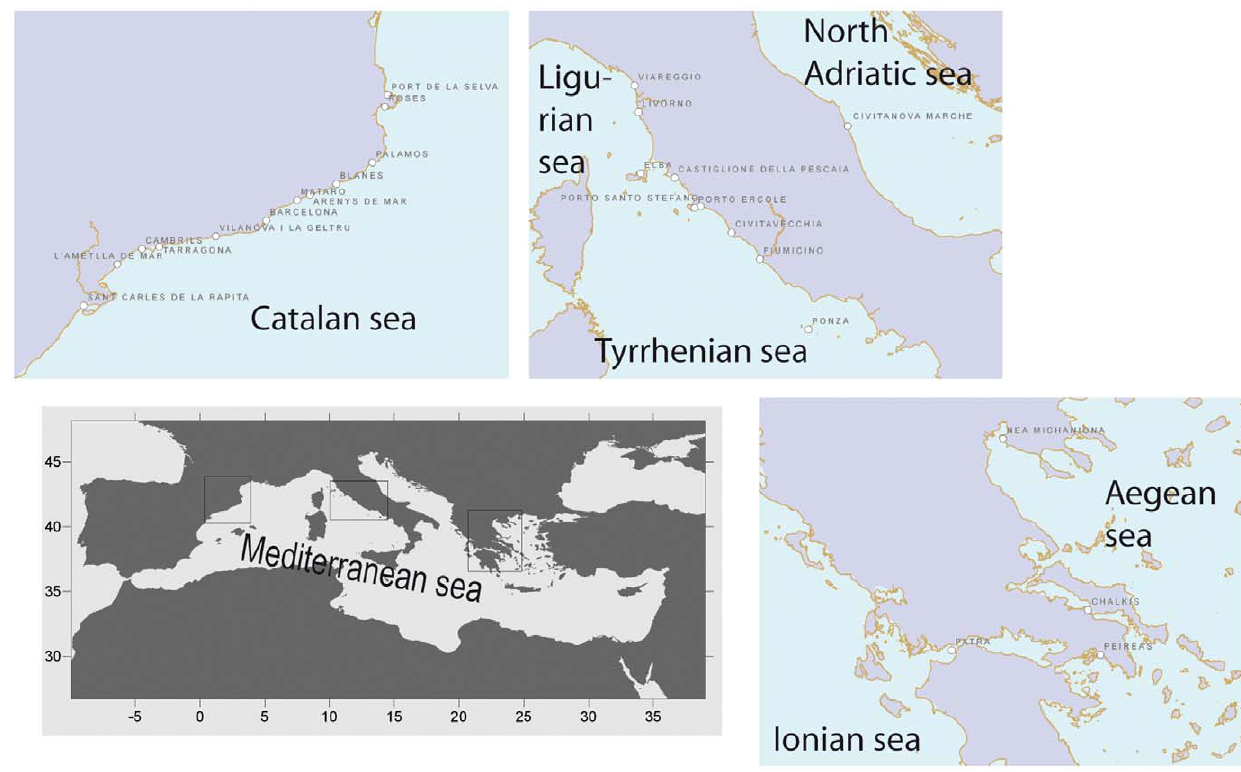
Figure 1. Study area. General map of the Mediterranean Sea with the port locations where the interview survey was carried out in each case study (Catalan Sea, Ligurian and Tyrrhenian Seas, North Adriatic Sea and Hellenic Seas).